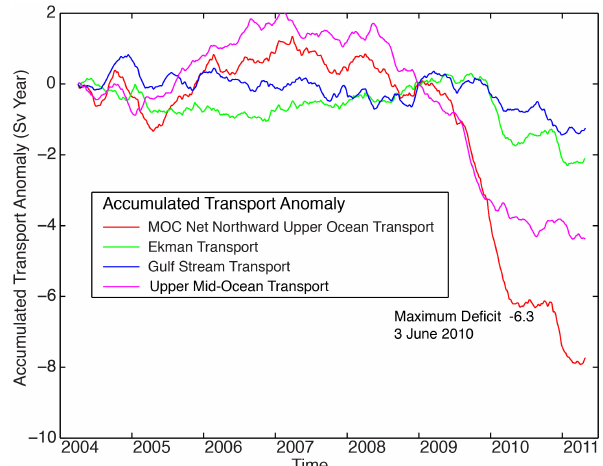
Figure 2. Accumulated Transport Anomaly during the Rapid event starting in early 2009. The normal AMOC is defined to be the average for each component for the first 4.75 years of the array, April 2004 to December 2008, where a seasonal cycle has been subtracted from each component prior to calculating the normal AMOC. The anomaly transport at each time for each component is defined as the difference between the instantaneous transport and the “normal” transport. Anomalous transport for each component is then accumulated over time. A local maximum accumulated trans- port deficit of 6.3Sv years is achieved on 3 June